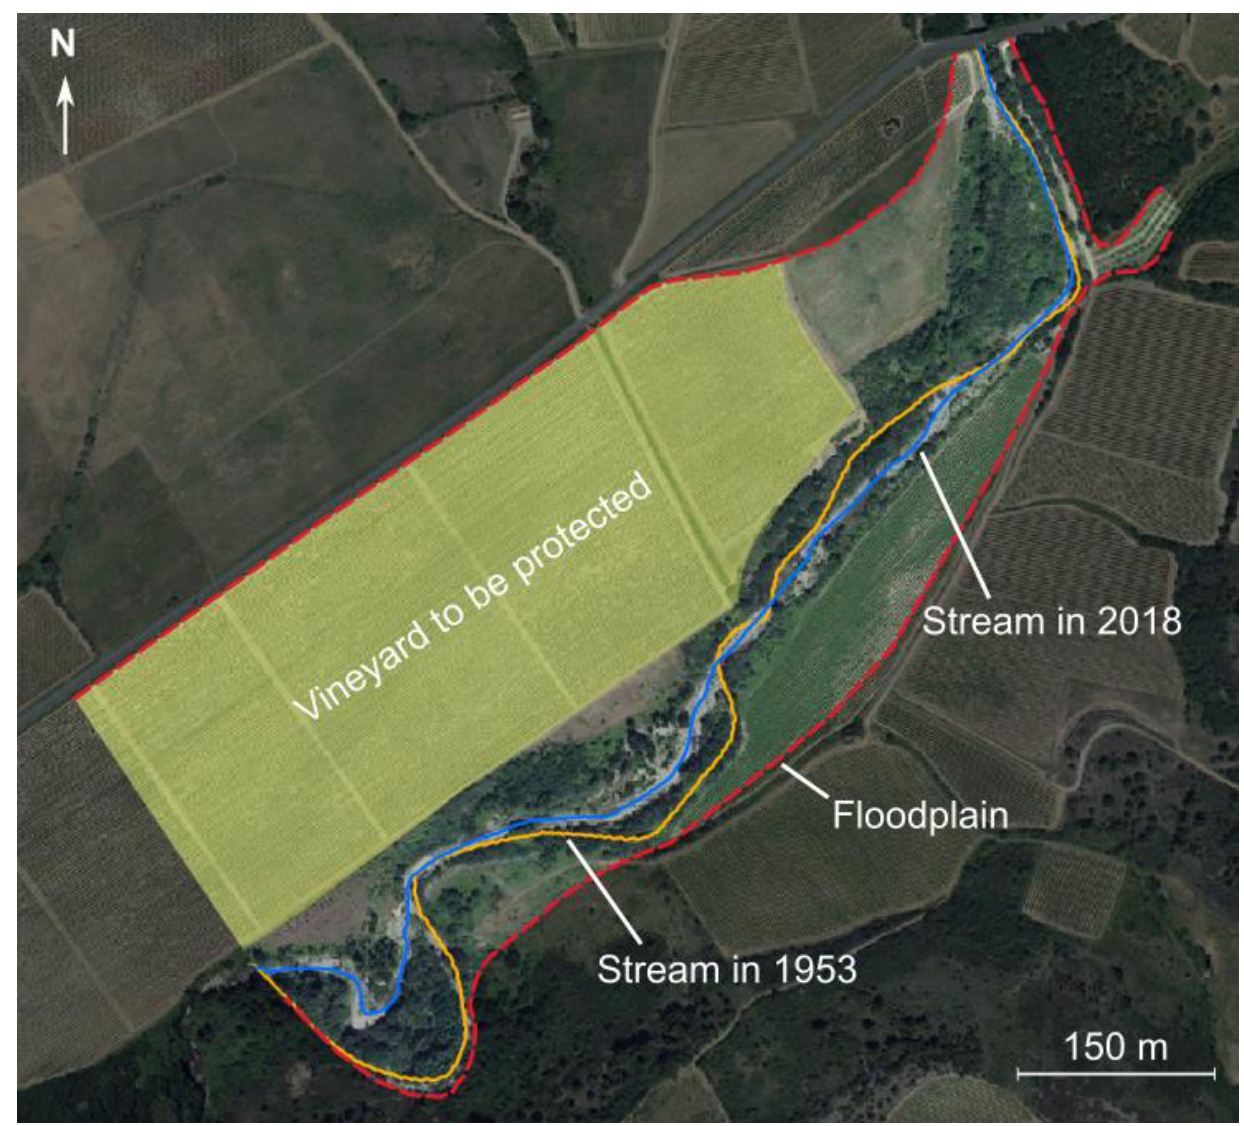
Figure 8. The studied site (Aygadons Bridge) in the Clamoux River.